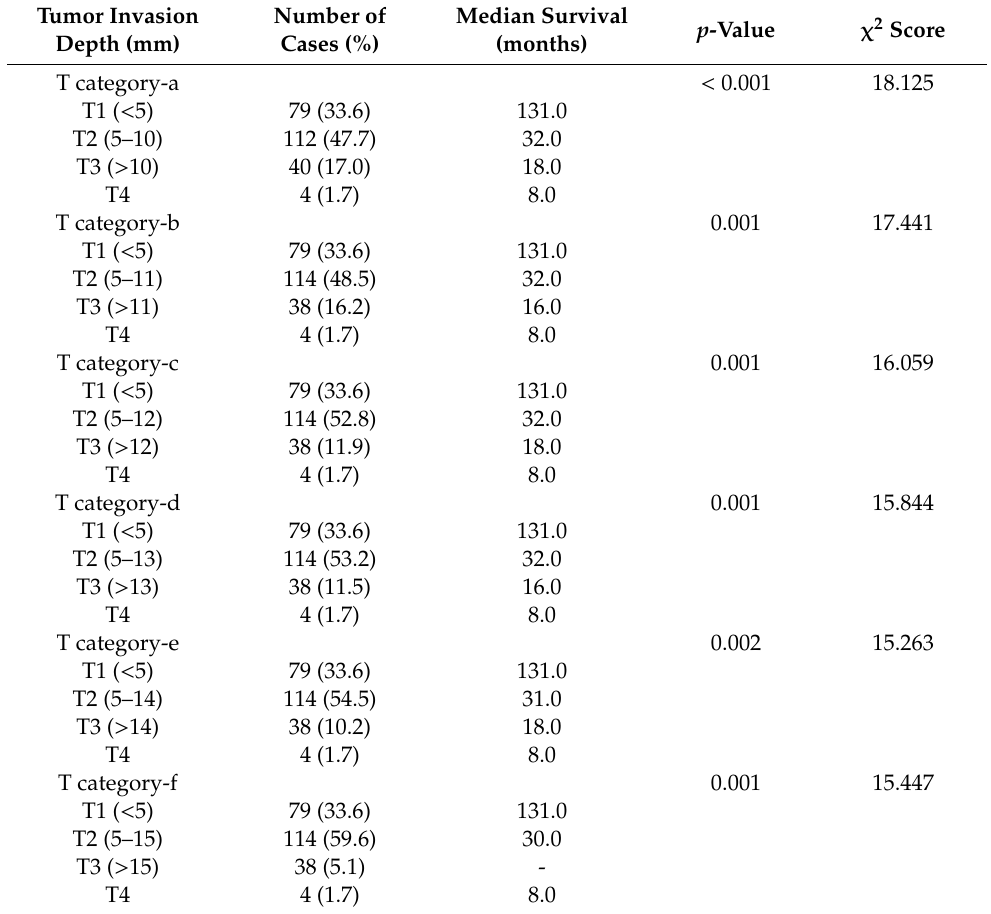
Table 2. Comparison for cuto ff values of each T